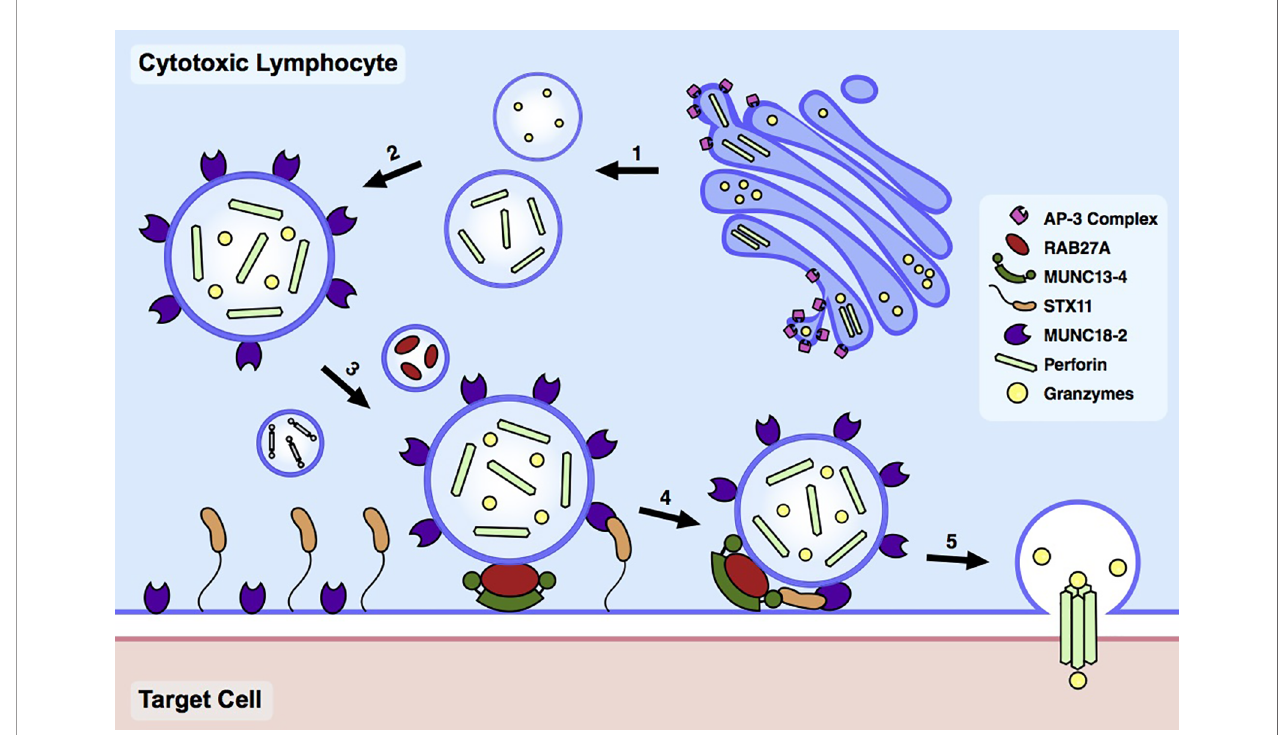
FIGURE 1 | Cytotoxic lymphocyte degranulation pathway. Upon target cell engagement, the degranulation pathway in cytotoxic lymphocytes undergoes a series of coordinated steps consisting of (1-2) cytotoxic granule biogenesis, (3-4) docking and priming, and (5) fusion and pore formation.